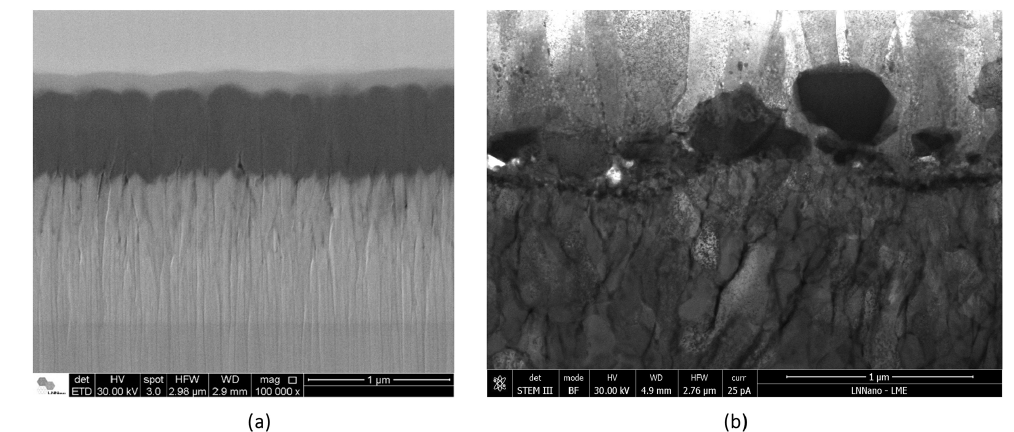
Figure 3. STEM image (a) of the morphology of the Cr interlayer SiC film and (b) of the layer formed by plasma